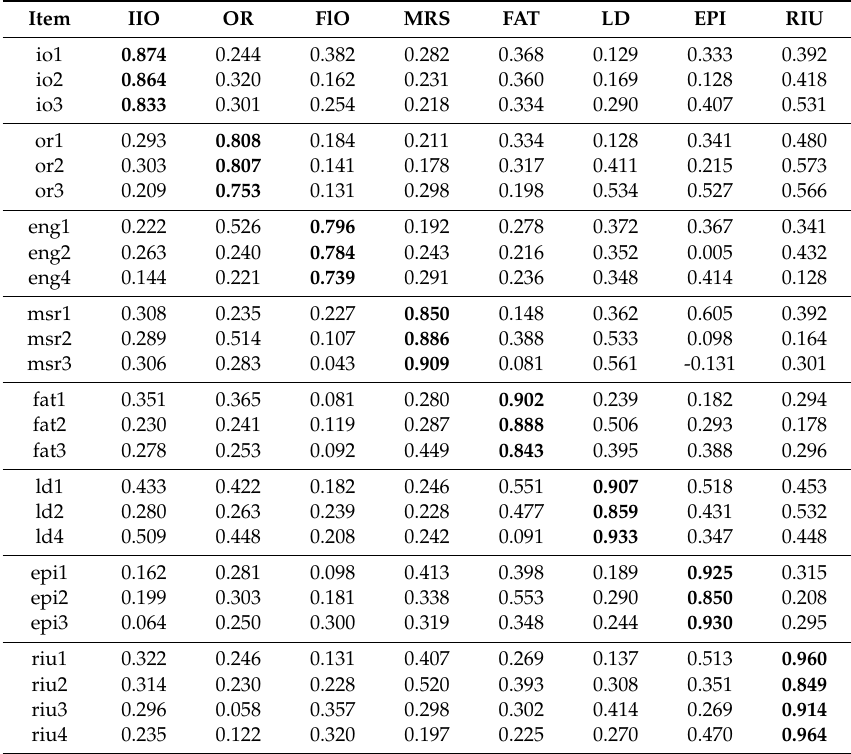
Table 6. Exploratory factor analysis